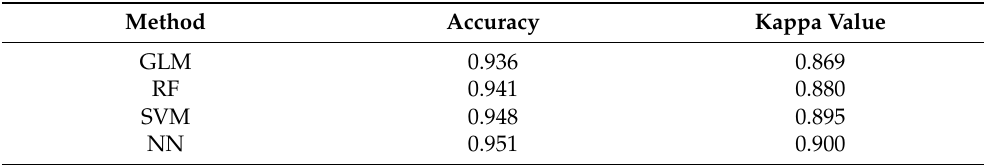
Table 2. Accuracy and Kappa value to compare methods performance on validation set. Prediction models were developed using four different machine learning methods: GLM, RF, SVM and